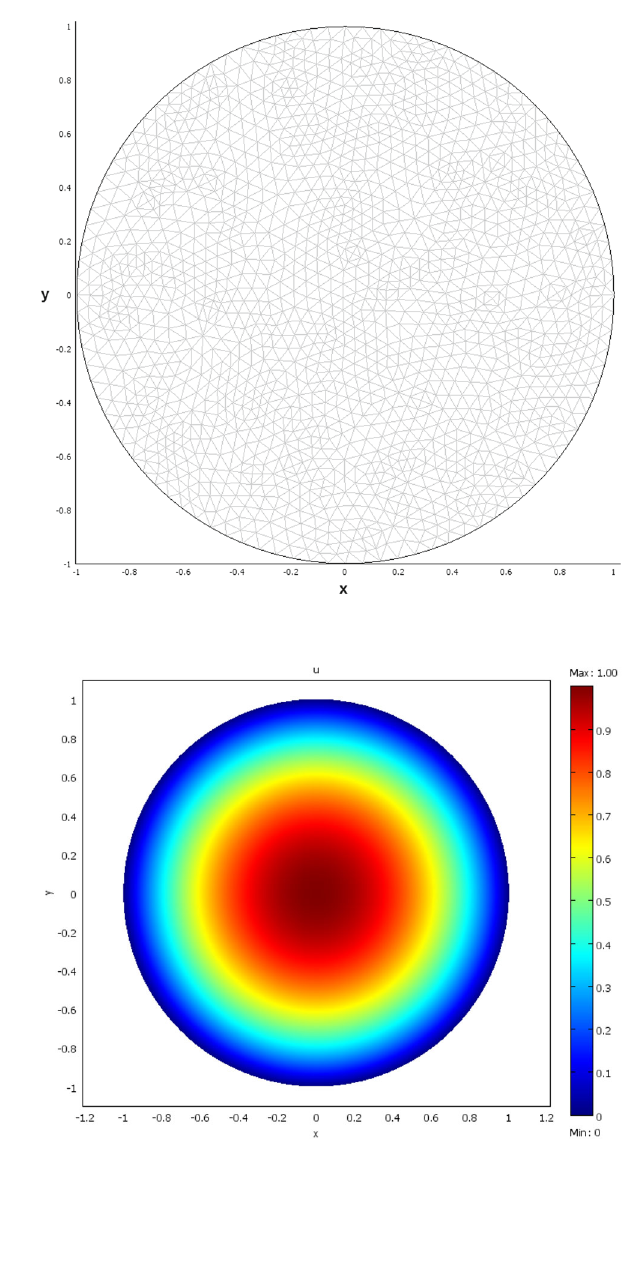
Fig. 2 Initial data: u